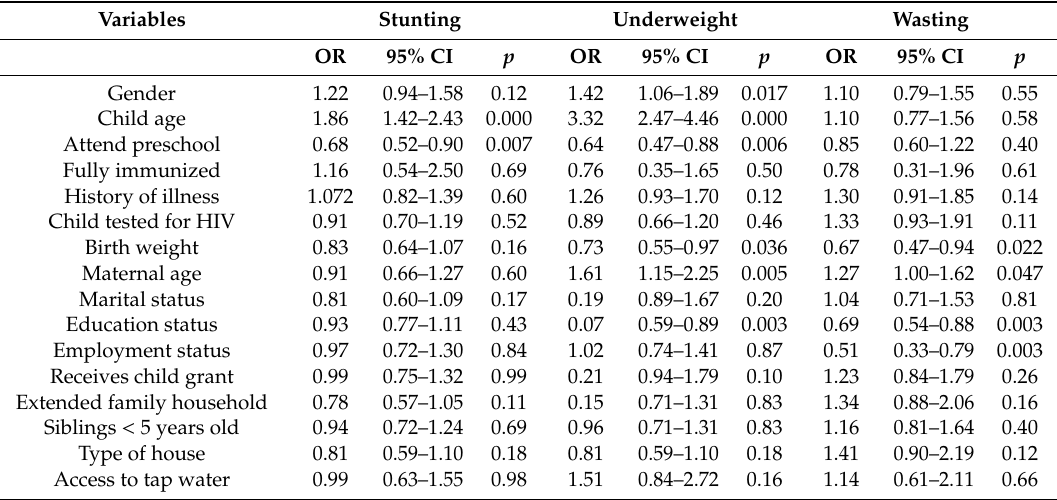
Table 3. Binary logistic regression for factors associated with stunting, wasting, and underweight in children under two years of